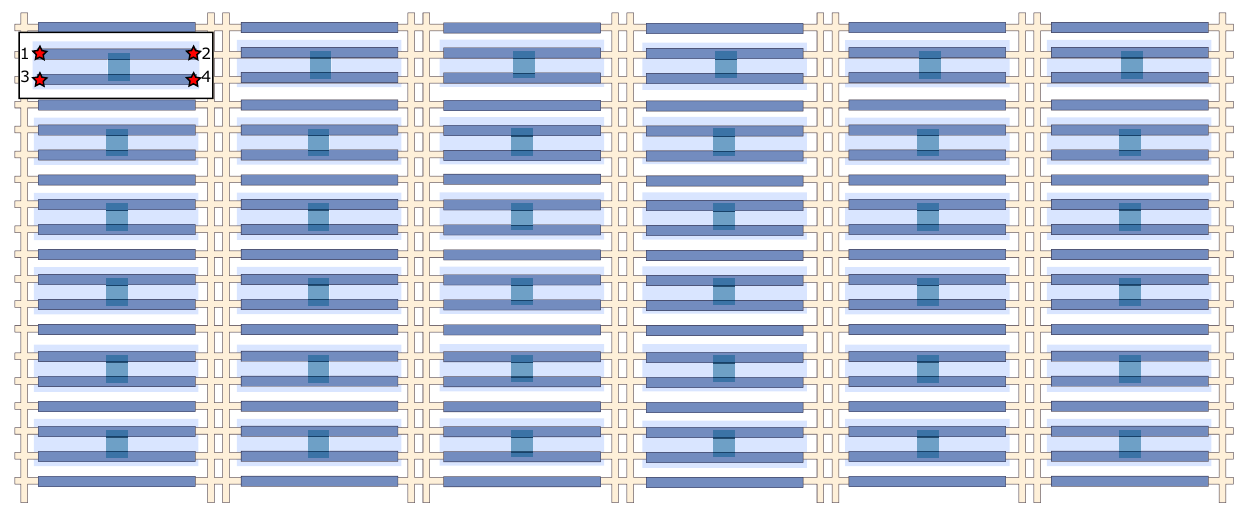
FIG. 3. The square lattice of tetrons used to implement the honeycomb and 4.8.8 Floquet codes. The topological superconducting wires (dark blue) have a MZM at either end. The qubit islands (light-blue shaded) correspond to two parallel topological wires joined by a trivial superconducting backbone (teal), with MZMs (red stars) labeled according to the box in the upper left. Rows of tetrons are separated by coherent links (floating topological wires). Neighboring qubit islands are connected by semiconducting segments (tan), with two semiconducting columns separating each column of qubits.